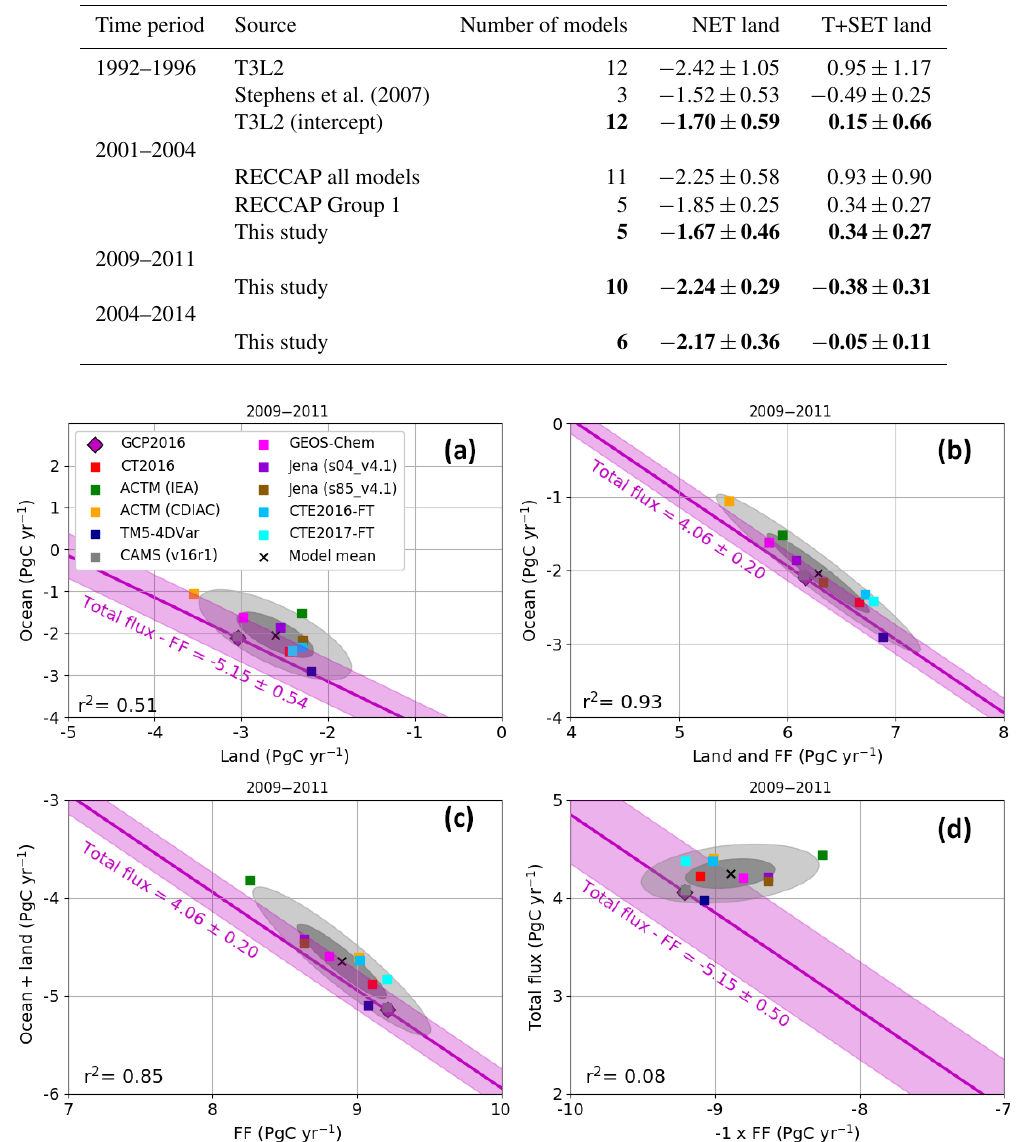
Table 2. Previous and our new best estimates (in bold) of the latitudinal partitioning of land fluxes over four time periods. All values are in PgCyr − 1 . Values are indicated by the model mean ± 1 standard deviation or 1 σ error uncertainties. Regarding the T3L2 period (Gurney et al., 2004), our new estimate for the 1992–1996 period comes from the intercept of the fit lines with the observations in Fig. 2b, and the uncertainties on these values come from the standard error on these metrics from the fits. Regarding the RECCAP period (Peylin et al., 2013), our new estimate for the 2001–2004 period is the average of the five new models from this study.